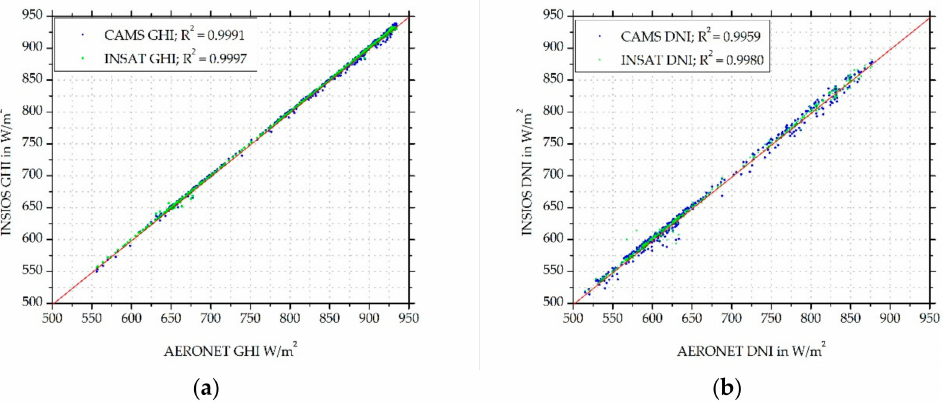
Figure 14. Absolute di ff erence in ( a ) GHI and ( b ) DNI (W / m 2 ) derived by INSIOS from BSRN data as a function of di ff erences in AOD from Aeronet and CAMS for all